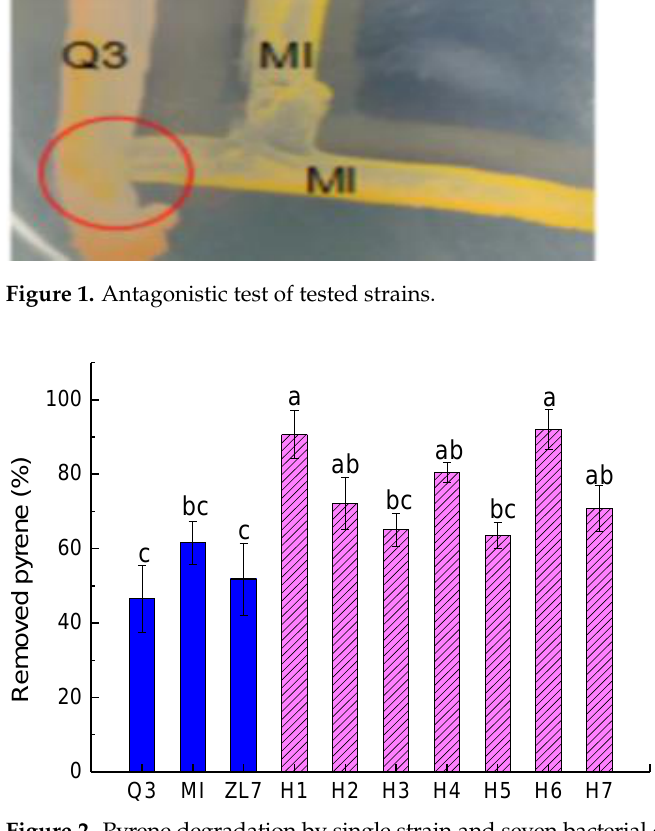
Q3 MI ZL7 H1 H2 H3 H4 H5 H6 H7 Figure 2. Pyrene degradation by single strain and seven bacterial consortia. Error bars represent the standard deviation ( n = 3). Different letters indicate the mean difference is significant between treatments at 0.05 level. H1 (ZL7:MI = 1:1), H2 (Q3:ZL7 = 1:1), H3 (Q3:MI = 1:1), H4 (Q3:ZL7:MI = 1:1:1), H5 (Q3:ZL7:MI = 2:2:1), H6 (Q3:ZL7:MI = 1:2:2) and H7 (Q3:ZL7:MI = 2:1:2).